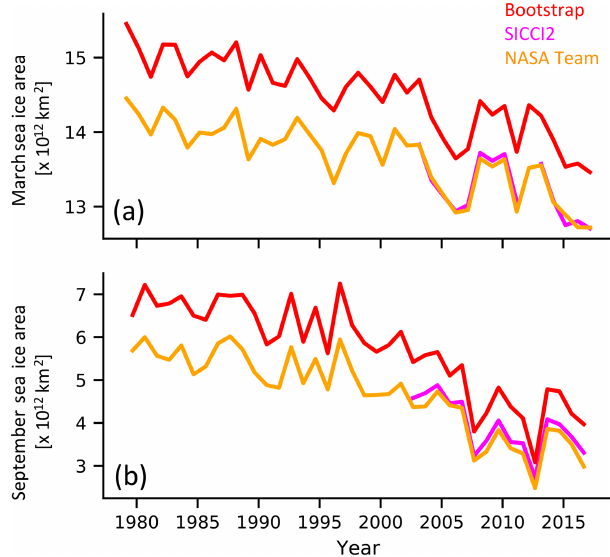
Figure 7. March (a) and September (b) sea ice area for the three ob- servational datasets assimilated in the three assimilation runs